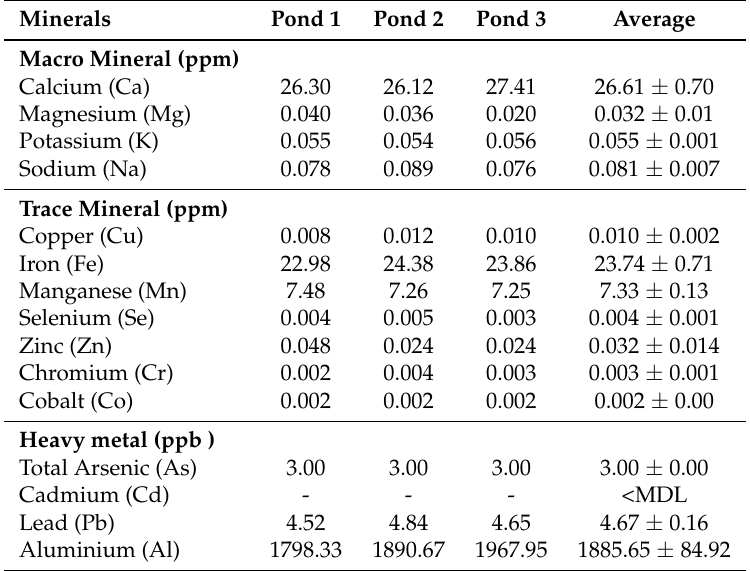
Table 5. Mineral content in cultivated C. racemosa